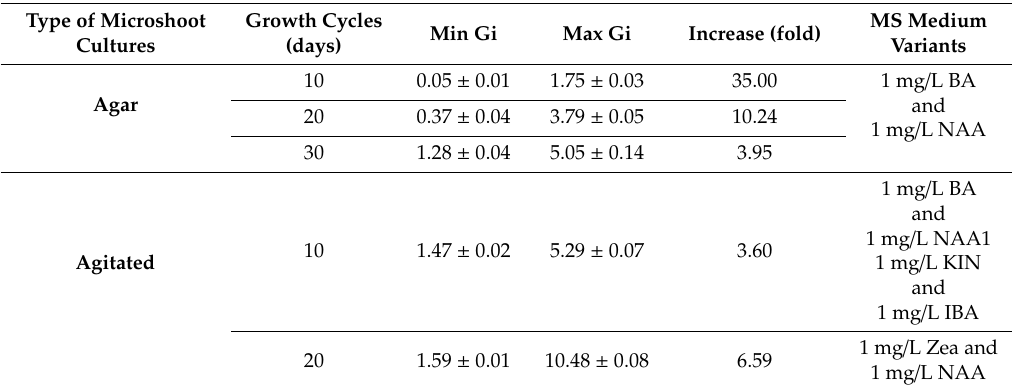
Table 1. The maximal values of the Gi of tested agar and agitated microshoots cultured under di ff erent duration of growth periods and composition of cytokinins and auxins in the MS media variants. Values represent the mean ( ± SD) of three experiments ( n = 5). Table is corresponding with Tables S2 and S3. Type of Microshoot